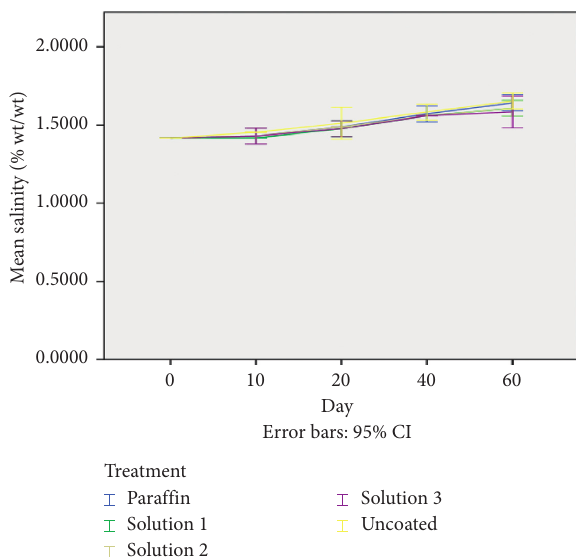
Figure 11: Values (means ± SD) of the salinity of cheese coated with antimicrobial edible coating solutions—solution 1 (0.250 g/L Delvocid), solution 2 (0.275g/L Delvocid), and solution 3 (0.300 g/ L Delvocid)—compared with cheese coated with commercial coating and uncoated cheese throughout 60d of storage at 10 ° C and 85% relative humidity.